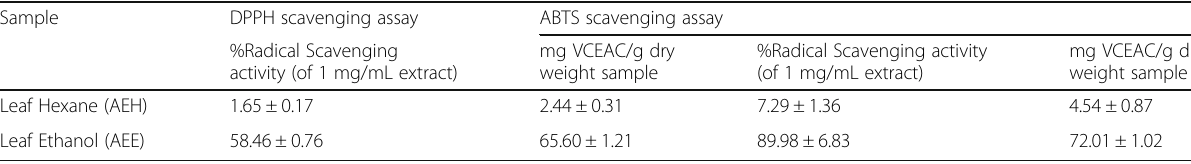
Table 3 Free radical scavenging activities of AE leaf extracts